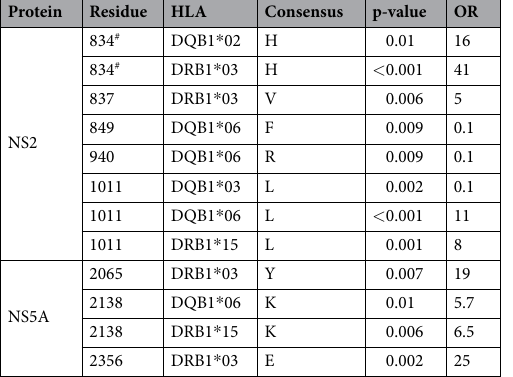
Table 1. HLA class II-associated HCV variations from a single source genotype 1B outbreak. Alleles associated with clearance (HLA-DQB1 * 02 and -DRB1 * 03) and chronicity (HLA-DQB1 * 06 and –DRB1 * 15) in this cohort 21 . Possible HLA-DRB1 and –DQB1 haplotypes indicated with a box. OR = odds ratio. N = 63. # Indicates possible extended haplotype with HLA class I allele (HLA-B *